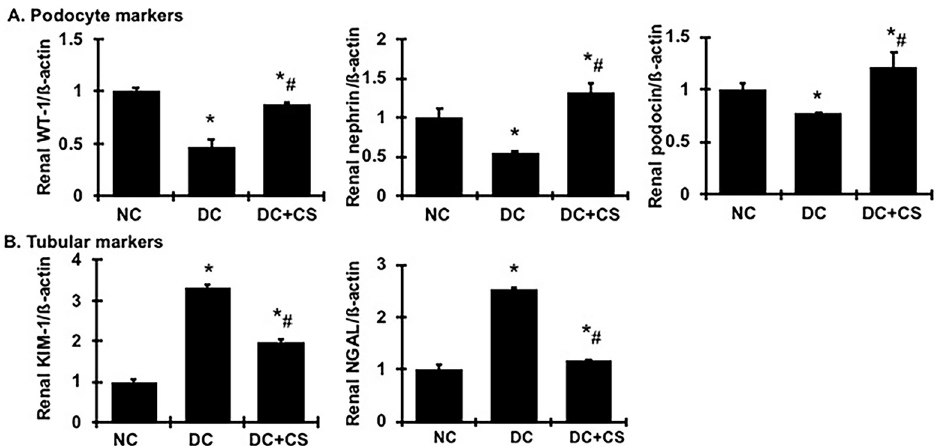
Figure 6. rBMSC sheets ameliorate mRNA expression of podocyte markers and tubular injury markers in CGN rats. ( A ) Expression of WT-1, nephrin, and podocin mRNA in renal cortex tissue. ( B ) Expression of KIM-1 and NGAL mRNA in renal cortex tissue. Expression of mRNA was determined by real-time RT/PCR. Changes in mRNA levels were determined by first correcting the amplification of ß-actin for each sample. * vs. normal control rats (NC), p < 0.05; # vs. disease control rats DC, p < 0.05. DC + CS, diseased rats received rBMSC sheets transplantation.